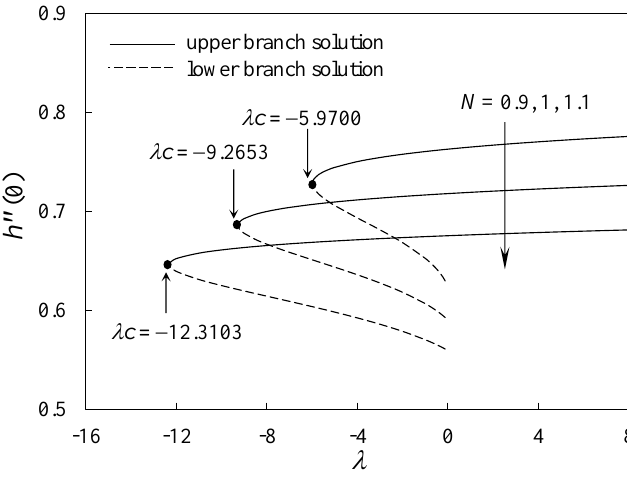
  0 h    0 h  Figure 4. Variation of with  for several values of N for Cu-water nanofluid. Figure 4. Variation of h (cid:48)(cid:48) ( 0 ) with λ for several values of N for Cu-water nanofluid. Figure 4. Variation of with  for several values of N for Cu-water nanofluid.